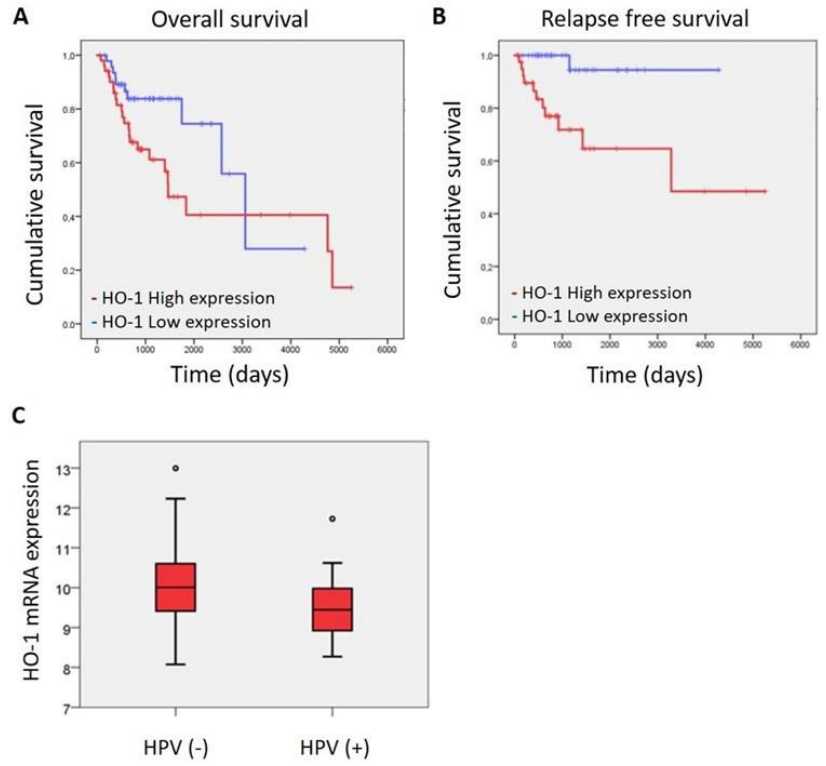
Figure 1. HO-1 mRNA expression is associated with overall survival, relapse-free survival and risk factor HPV status. ( A ) Kaplan – Meier overall survival curves for HNSCC patients stratified as Stage 1 + 2 according to low and high HO-1 expression level ( n = 217, Breslow test, p = 0.046). ( B ) Kaplan–Meier relapse-free survival curves for HNSCC patients stratified as Stage1 + 2 according to low and high HO-1 mRNA expression level ( n = 217, Log Rank test, p = 0.003). ( C ) Comparison of HO-1 mRNA levels in HNSCC according to HPV status ( n = 88, ANOVA test, p = 0.034).